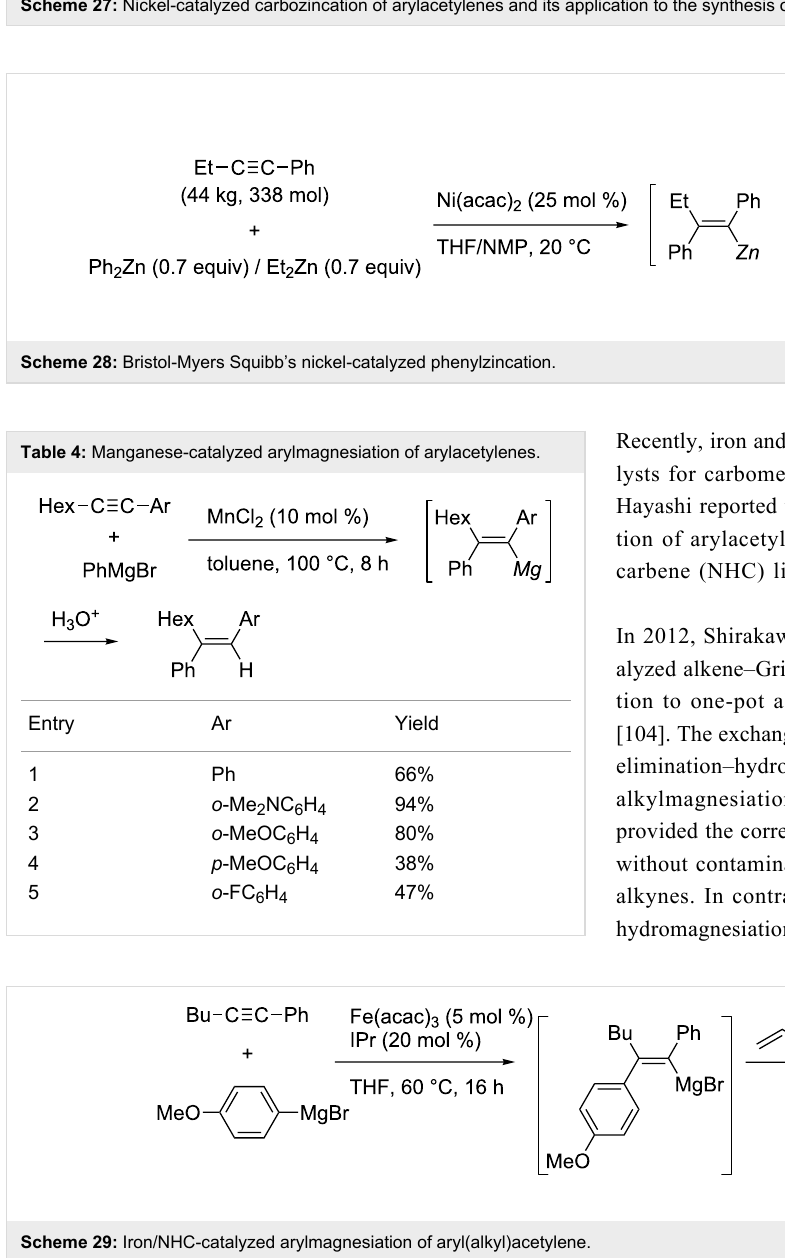
Scheme 27: Nickel-catalyzed carbozincation of arylacetylenes and its application to the synthesis of tamoxifen.